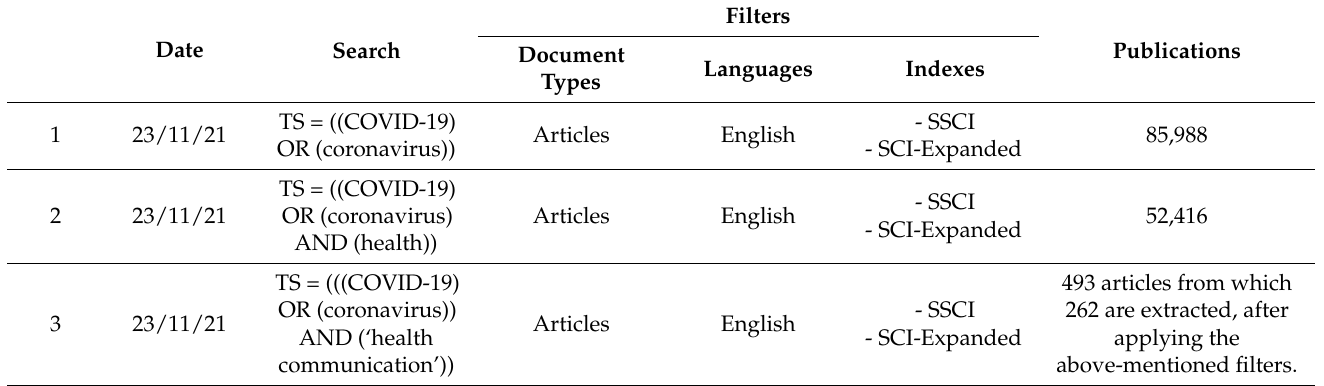
Table 1. Results of the searches carried out in the selection of archives for the bibliometric